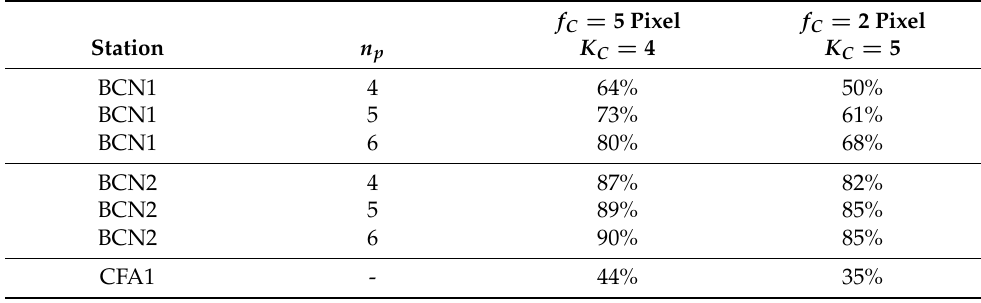
Table 6. Percentage of automatically calibrated images satisfying f (cid:54) f C and K (cid:62) K C for different stations and basis and for the years in Table